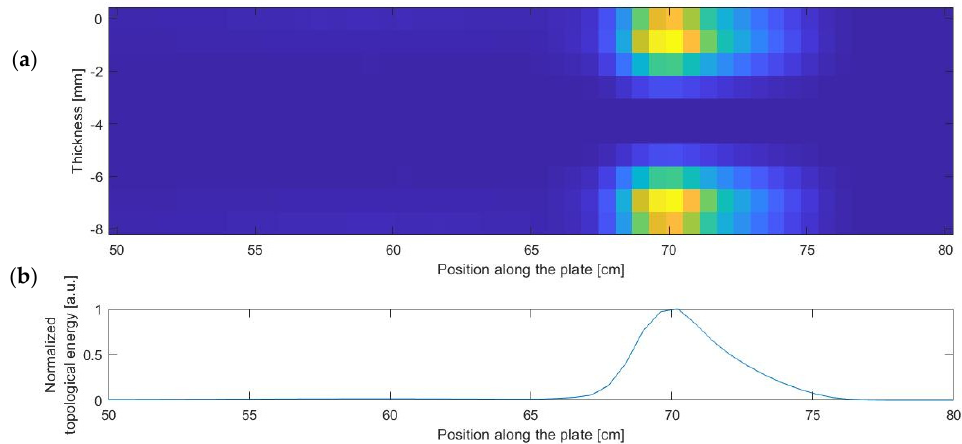
Figure 9. ( a ) Topological image in the zone of interest of the simulated plate; ( b ) Normalized sum of the topological energy at each position along the plate.